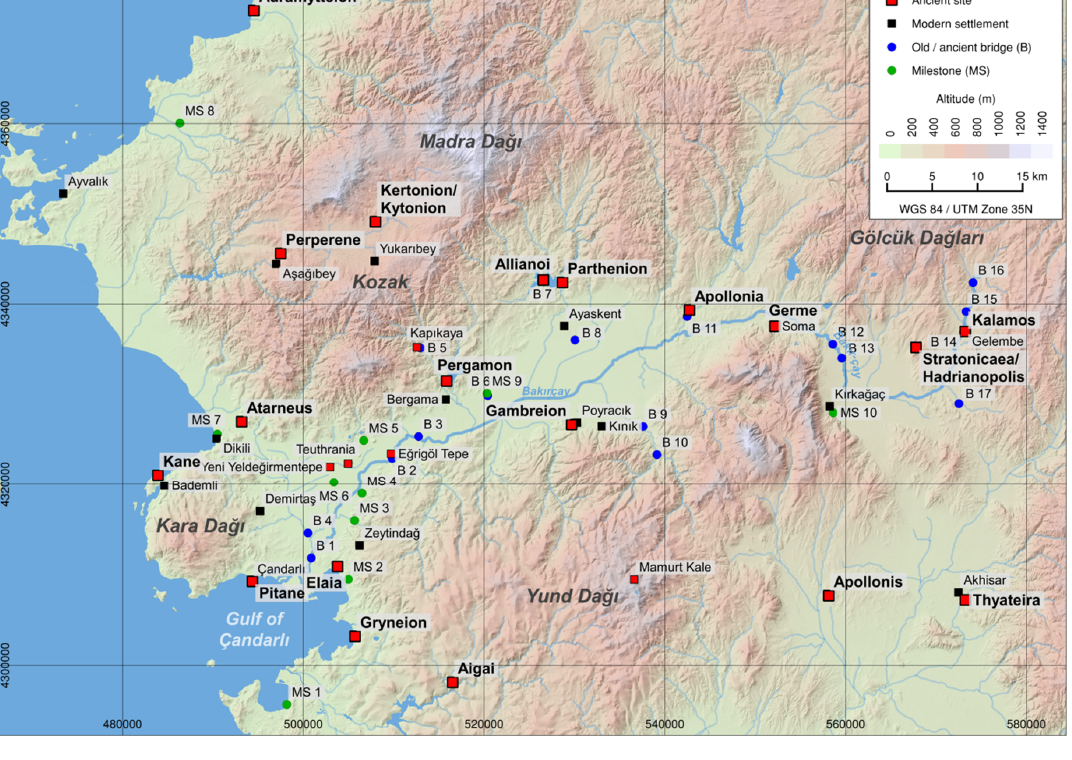
Figure 3. Study area with the location of bridges and milestones mentioned in the text.